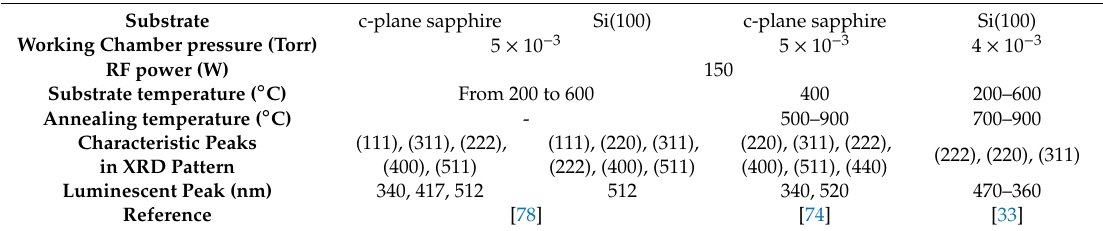
Table 3. Comparisons of photoluminescence (PL) peaks and crystalline orientations with di ff erent process parameters in the sputtering process.